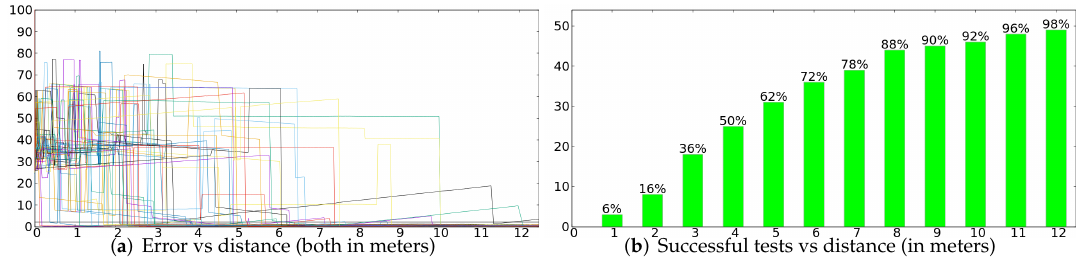
Figure 7. Results correspond to 50 executions where the robot has followed different